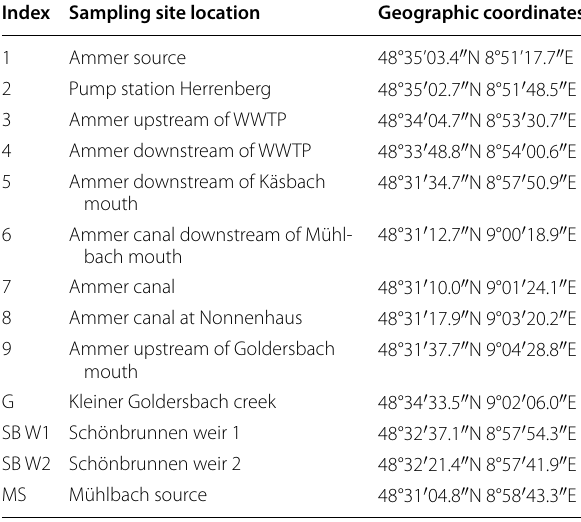
Table 1 Numbering and description of the sampling locations, in accordance with Fig.